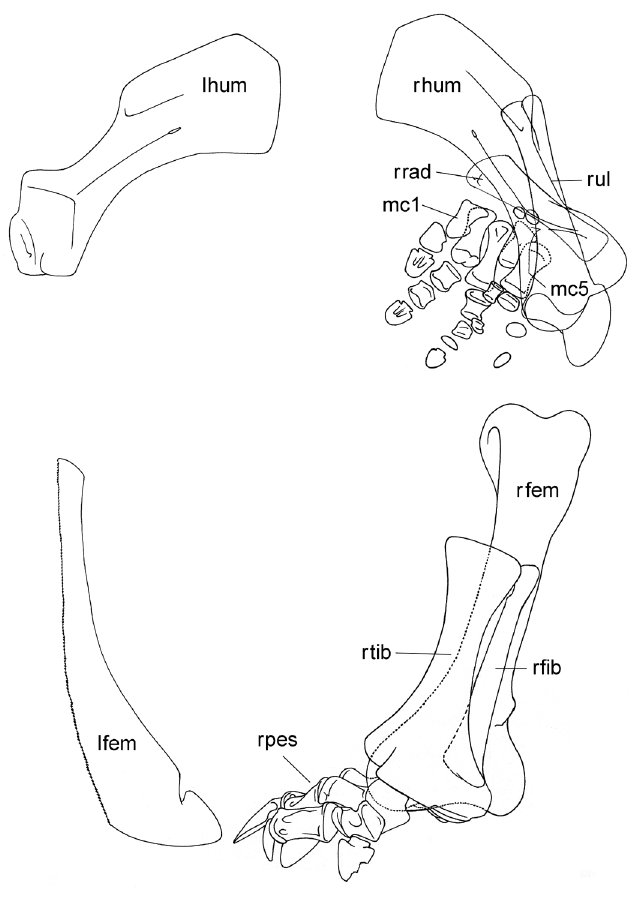
Figure 16. Specimen map showing the relative position of limb elements. Adapted and simplified from a map prepared by D. Stoffregen. Vagaceratops irvinensis , CMN 41357.